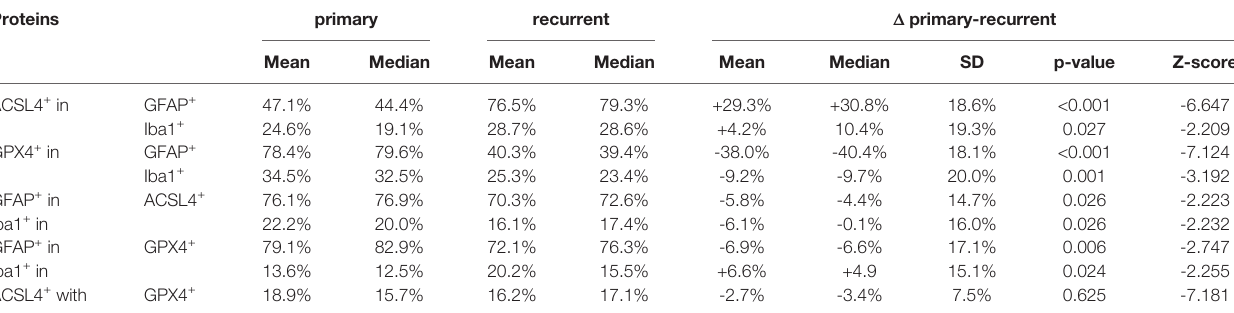
TABLE 5 | Summary of results of co-expression analysis by immuno fl uorescence.